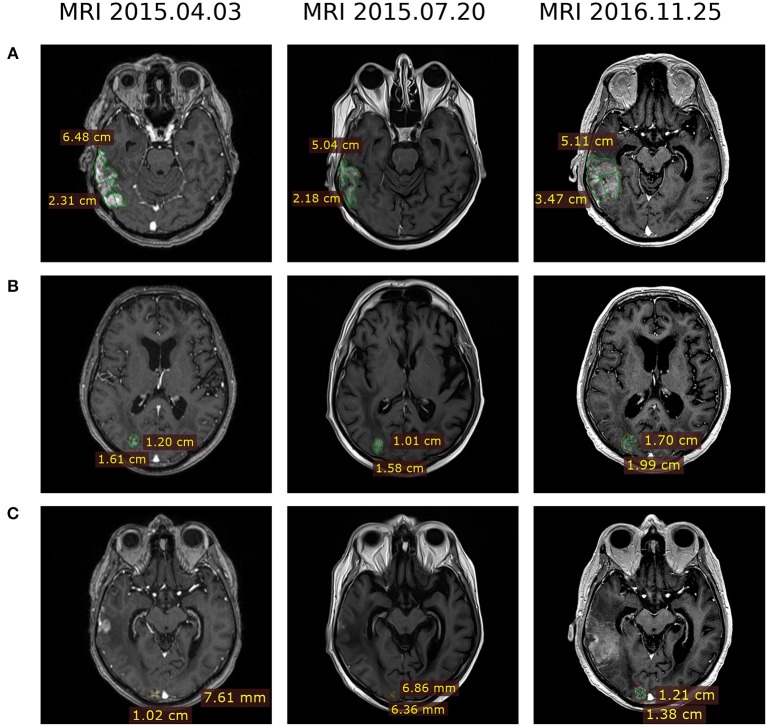
MRI evaluation of brain metastases dynamics at therapy lines 3 and 4 after development of the ceritinib resistance. Treatment regimens were pemetrexed + cisplatin (2015.04.03), topotecan followed by crizotinib (2015.07.20) and crizotinib + bevacizumab (2016.11.25). (A) Lesion 1, right temporoparietal region. (B) Lesion 2, right occipital lobe. (C) Lesion 3, right occipital lobe.